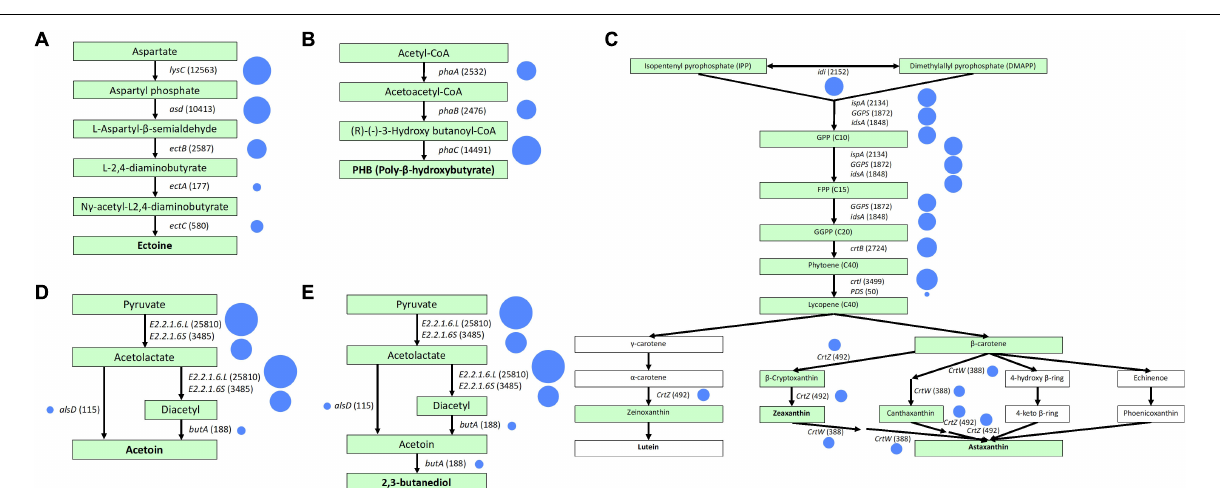
FIGURE 4 | Gene-mapping to KEGG reference pathways for valuable products including (A) ectoine, (B) PHB, (C) lutein, zeaxanthin, and astaxanthin, (D) acetoin, and (E) 2,3-butanediol. A continuous arrow shows biosynthesis pathways. Chemical substances in boxes are generated by microbial reactions. Boxes in green indicate the presence of the metabolic reaction. Functional genes and the hit numbers are indicated next to the arrows. Circle size corresponds to the number of